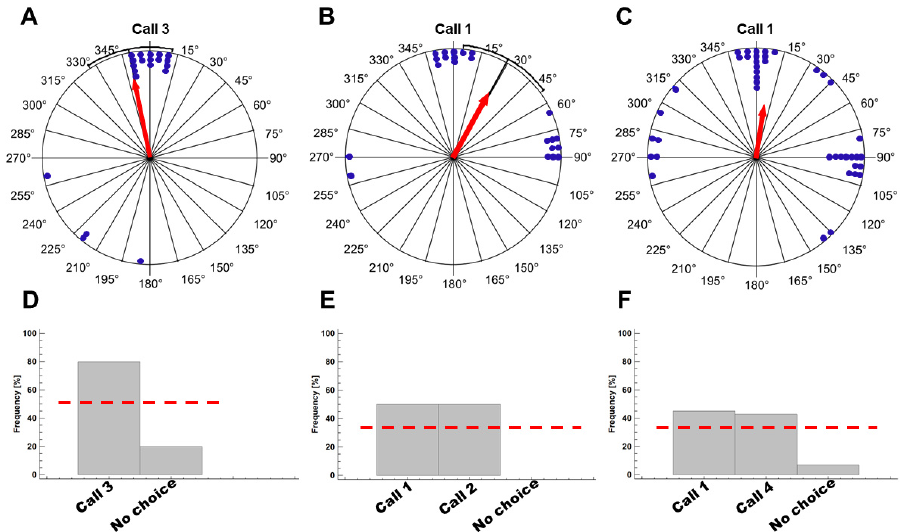
Figure 5. Phonotactic orientation of reproductive R. arenarum females. ( A – C ) Initial orientation. The circular distribution of females’ directional choice (blue dots) is standardized to a loudspeaker position of 0°. Significant mean vectors are shown as red arrows. ( D – F ) Final orientation. Grey columns give the frequency of directional decisions, dashed red line the expected frequency of a chance decision among loudspeaker positions and no choice. Details are given in the text.